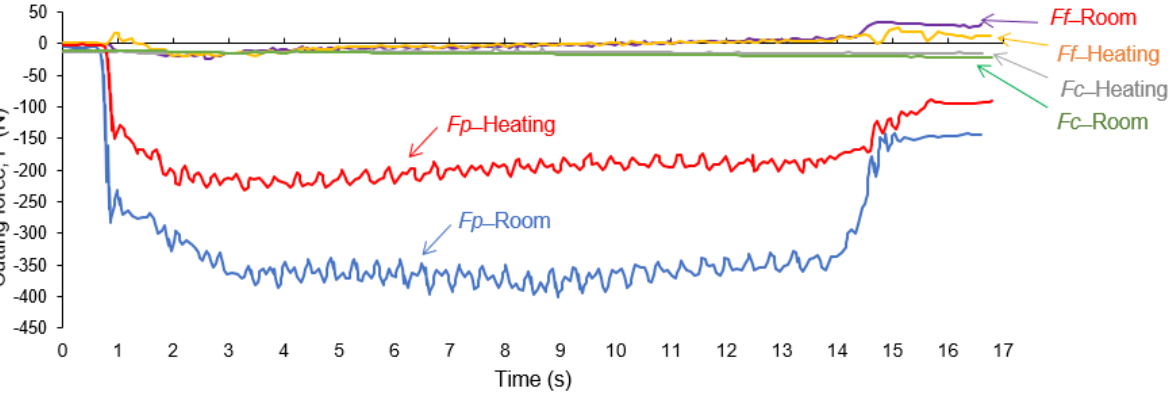
Figure 7. Cutting force during machining at room temperature and at elevated temperature (200 °C). Table 2. Average cutting force at room and elevated